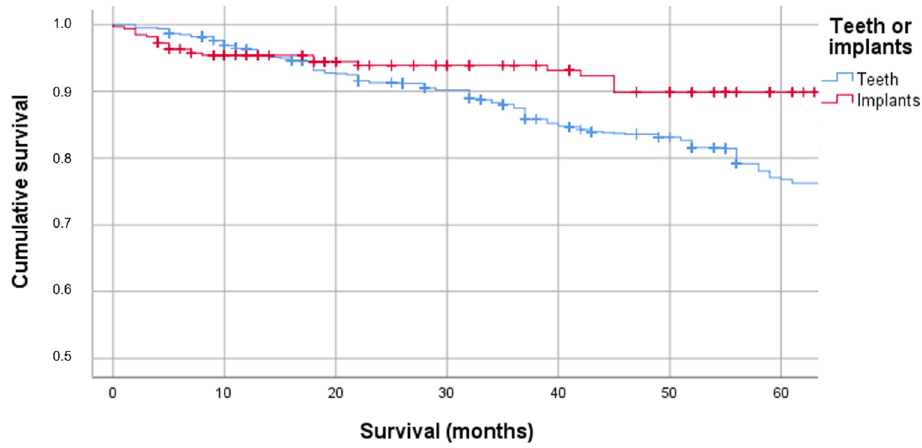
Figure 1. Cumulative survival of teeth and implants after tumor therapy.